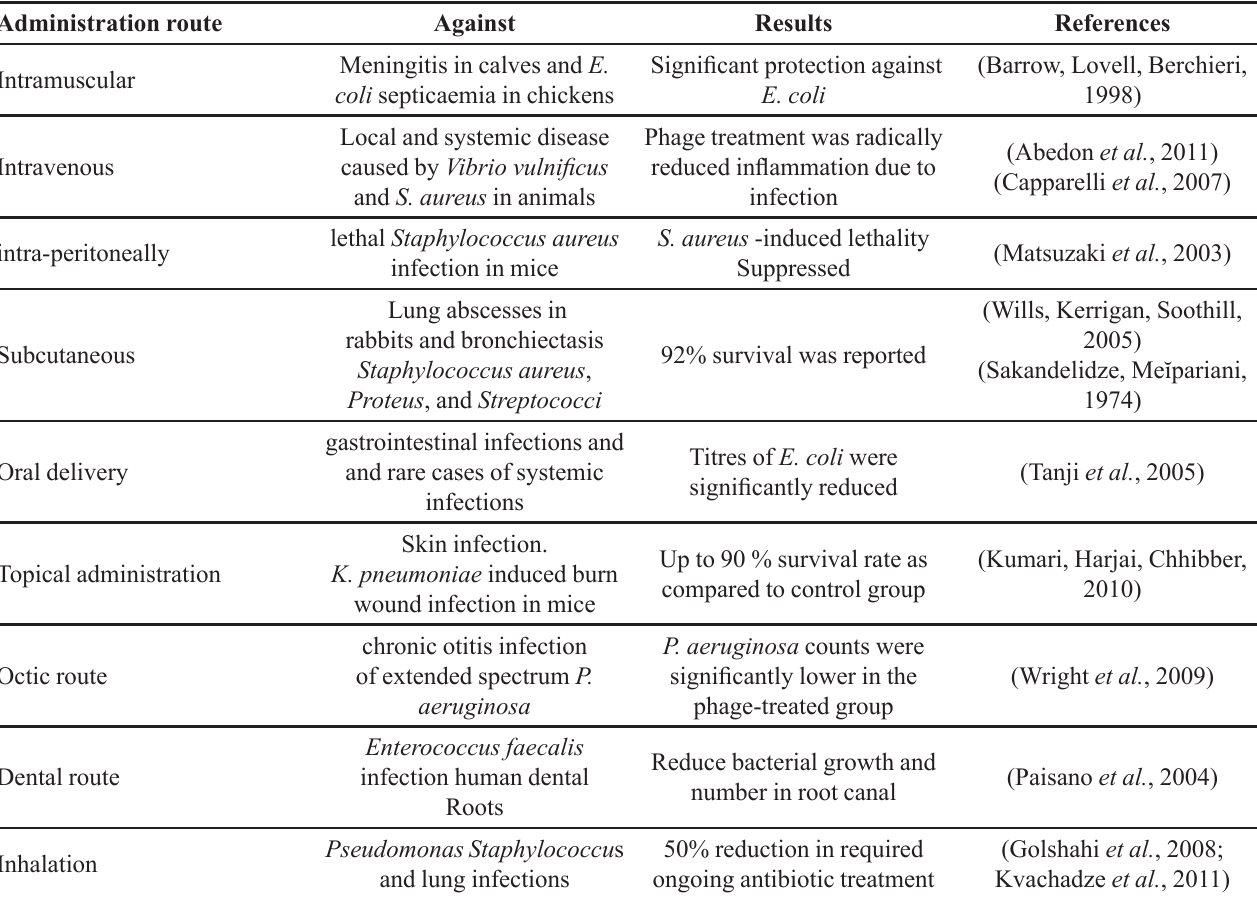
TABLE II - Administration routes of phage therapy adapted in different pre-clinical and case study in humans Administration